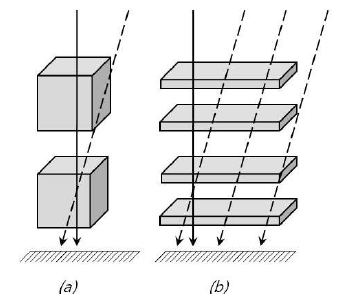
Figure 1. The relationship between the trace of airborne laser- beams (arrows) and the spatial unit (hexahedra) employed for a study. The solid and dashed arrows show the lasers from zenith direction and from at an incident angle, respectively. The cases are described for the spatial units with (a) no limitation in the size, and (b) with the limitation in the size of large area and thin layer